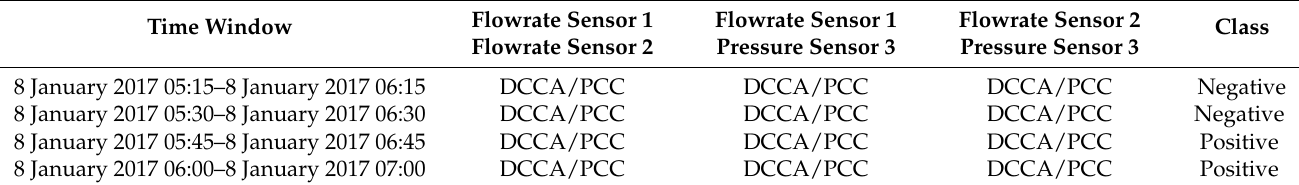
Table 1. Illustrative data instances produced from 3 sensors and a time window of 60 min. Time